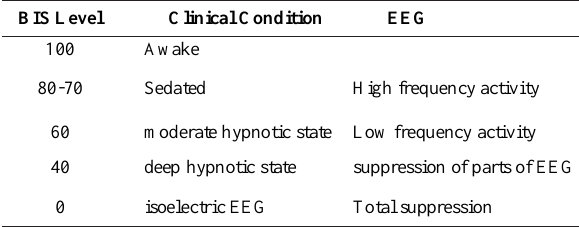
Table 6. Relation between the clinical state of the patients and BIS, altered for the use of hypnotic